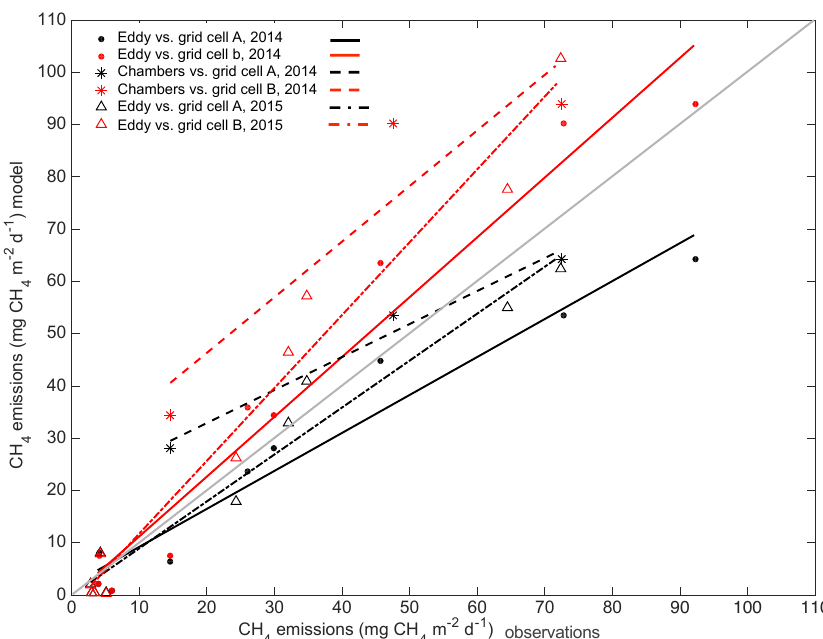
Figure 4. Comparison between modeled CH 4 emissions and flux measurements by chambers and EC in the Chersky floodplain: correlation between results for model grid cells A and B and measurements during 2014 and 2015 (the light grey line is the 1 : 1 line).